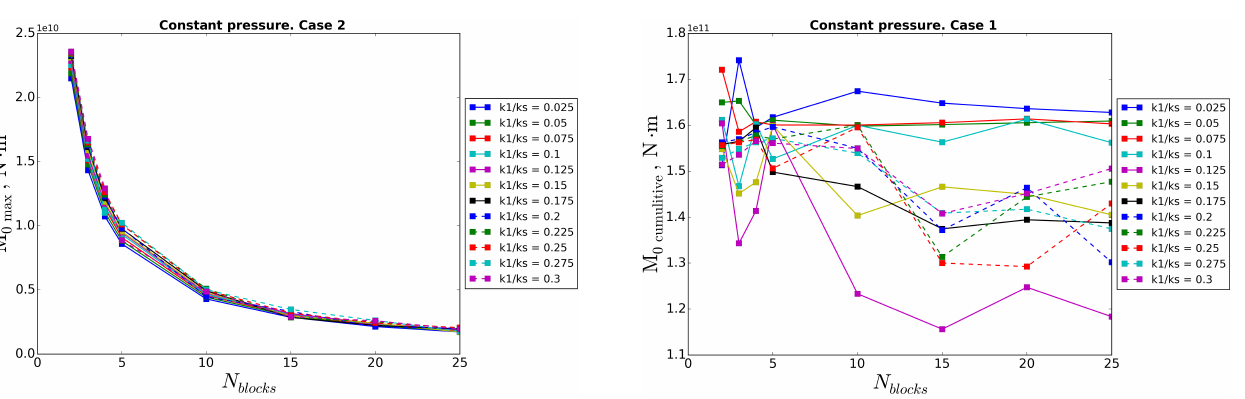
Figure 13. Cumulative seismic moment vs. number of blocks.